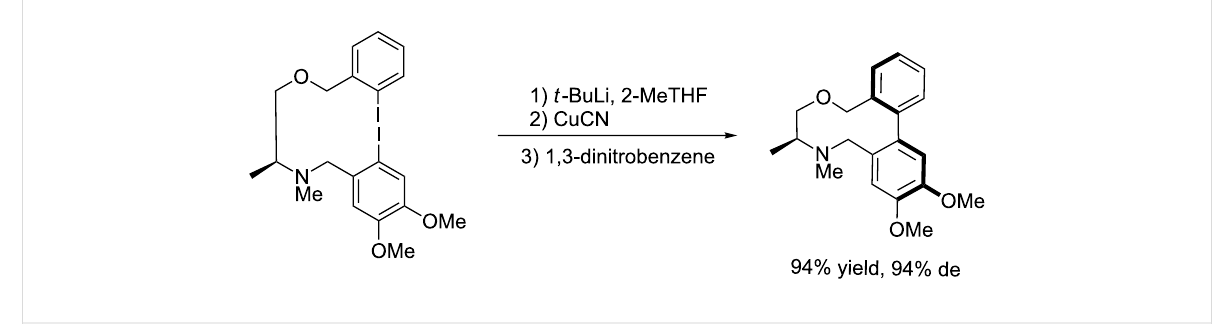
Scheme 13: Synthesis of chiral unsymmetrically substituted biaryl compounds.